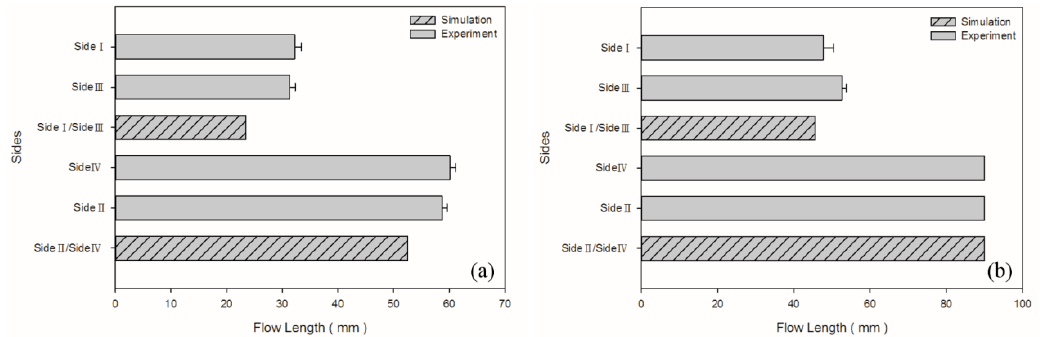
Figure 5. Experimental and simulated flow lengths for medium-level parameters in the process: ( a ) PP matrix and AC CBA; ( b ) PS matrix and AC CBA.